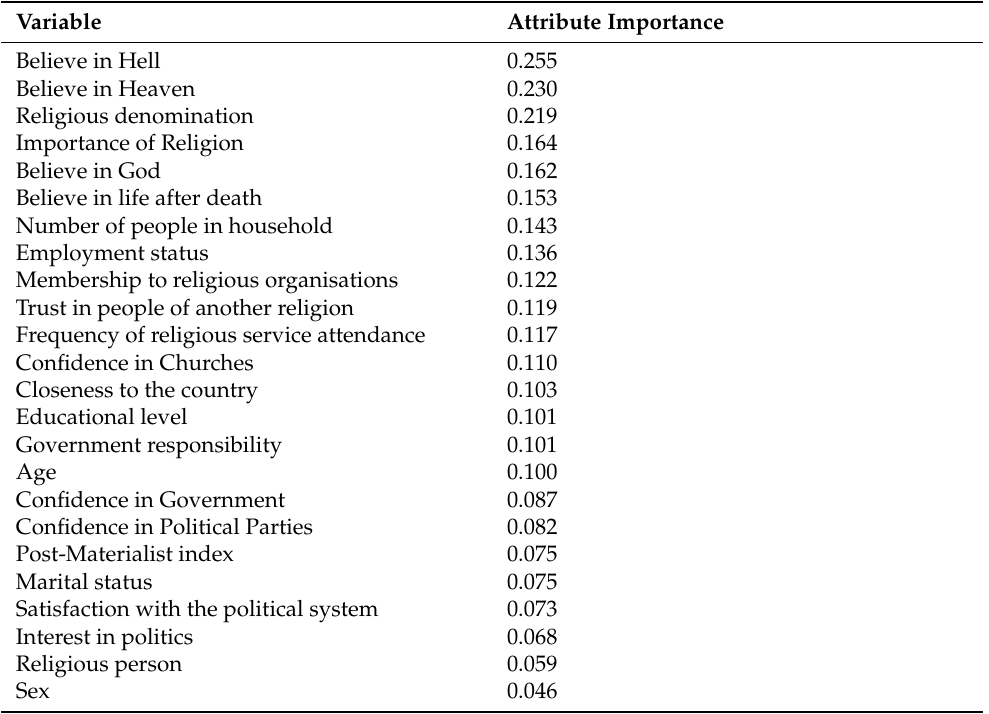
Table 2. The empirical results of chi-squared feature